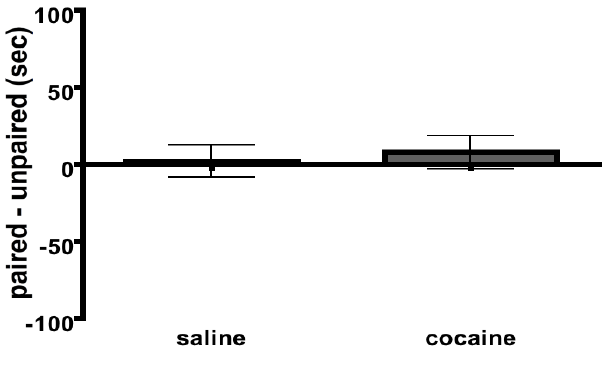
Figure 3. Extinction. All rats extinguish. There were no effects of Pretreatment on extinction. Same rats from Figure 2. Bars denote means and